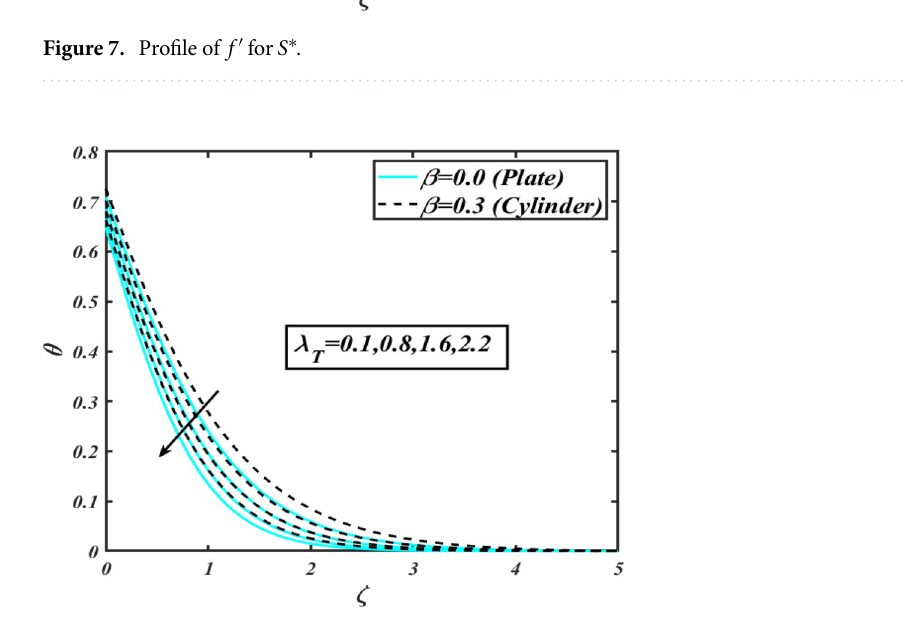
Figure 8. Profile of θ for (cid:31) T